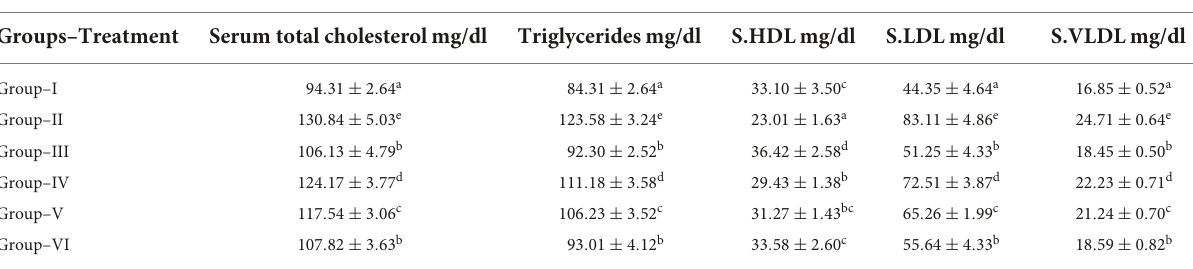
TABLE 4 Effect of ethanolic extract of Solanum torvum fruits on lipid profile in streptozotocin (STZ)-induced diabetic Sprague–Dawley (SD) rats.